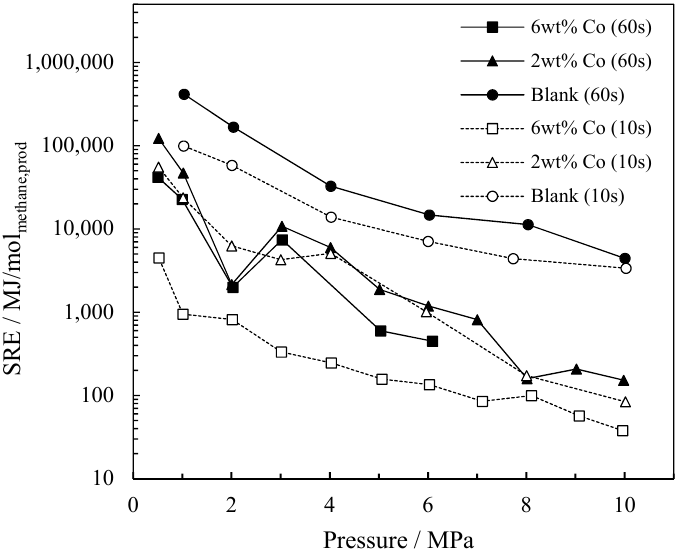
Figure 6. Specific required energy (MJ/molmethane,prod) as a function of pressure for plasma-catalytic FTS (NTP + Blank, 2 or 6 wt% Co catalyst) at discharge time of 10 and 60 s. Legend: ■ —6 wt% Co (60 s); ▲ —2 wt% Co (60 s); ● —Blank (60 s); □ —6 wt% Co (10 s); Δ —2 wt% Co (10 s); ○ — Blank (10 s). Operating conditions: Syngas (H 2 /CO) ratio: 2.2:1; current: 350 mA; inter-electrode gap: 1 mm; wall temperature: 25 °C.